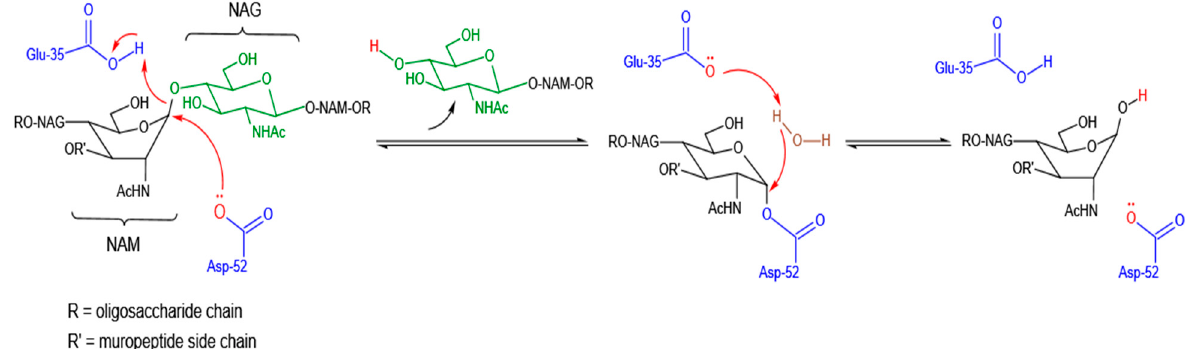
Figure 1. Hydrolytic mechanism of action of lysozyme on β (1–4) linkages between NAM and NAG residues of the bacterial cell wall backbone. residues of the bacterial cell wall